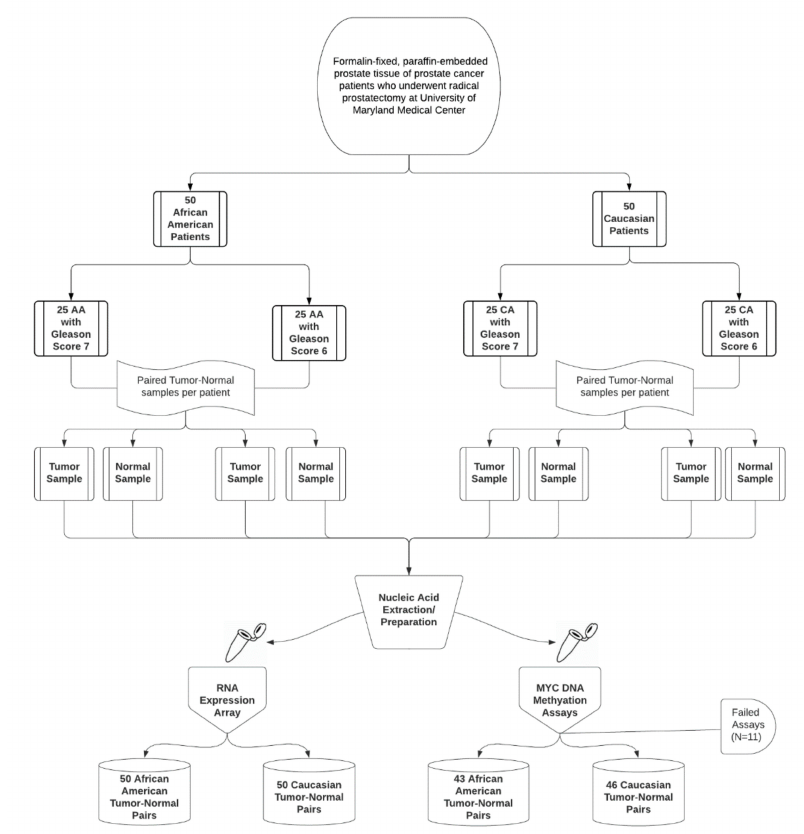
Figure 1. Study workflow for the University of Maryland samples. Abbreviations: AA, African American; CA,